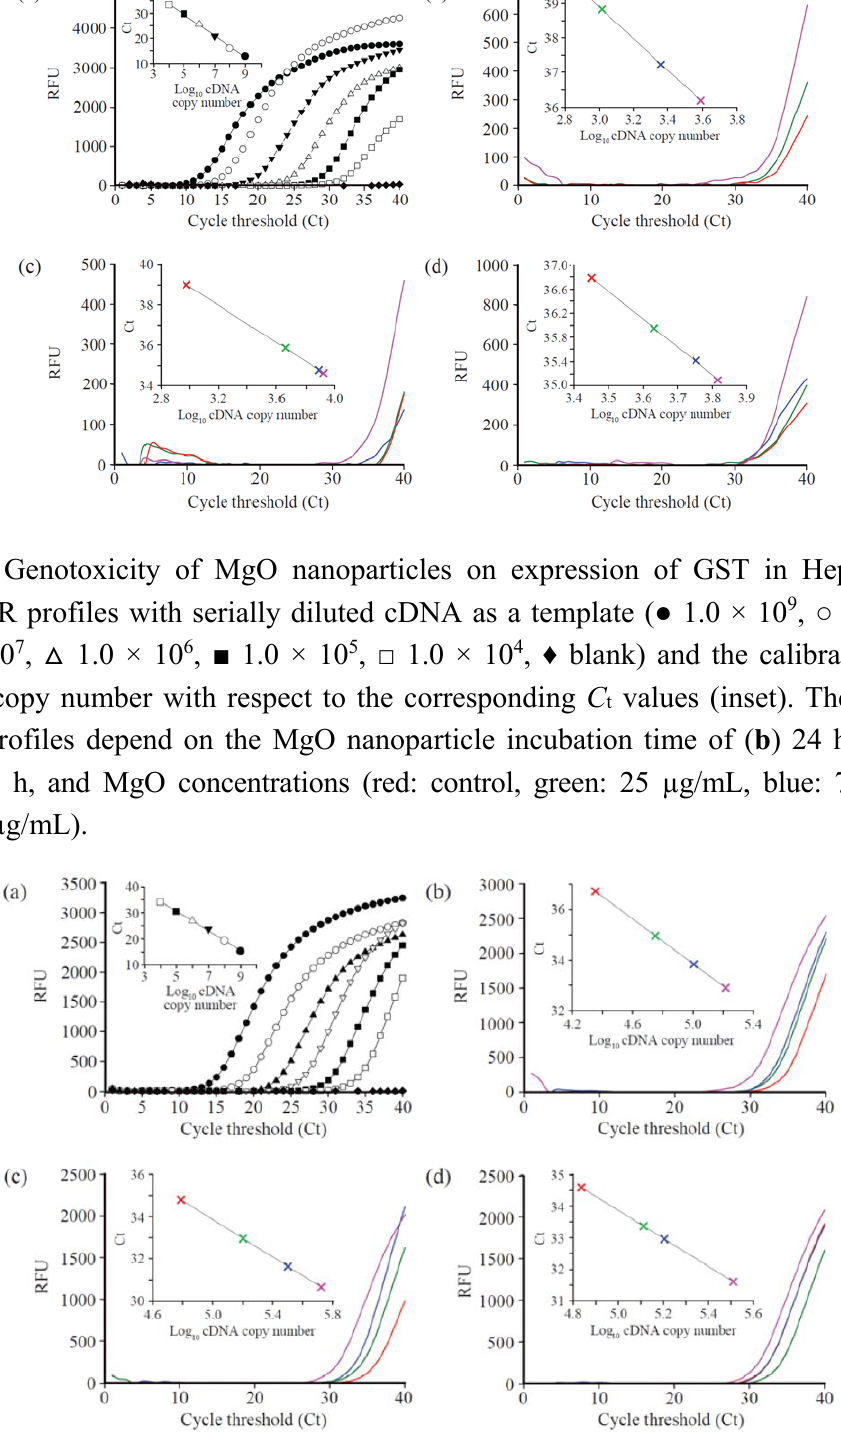
Figure 2. Genotoxicity of MgO nanoparticles on the expression of catalase in HepG2 cells. ( a ) RT-PCR profiles with serially diluted cDNA as a template (● 1.0 × 10 9 , ○ 1.0 × 10 8 , ▼ 1.0 × 10 7 , 1.0 × 10 6 , ■ 1.0 × 10 5 , □ 1.0 × 10 4 , ♦ blank) and the calibration curve of the cDNA copy number with respect to the corresponding C t values (Inset). The RT-PCR △ profiles depend on the MgO nanoparticle incubation time of ( b ) 24 h, ( c ) 48 h and ( d ) 72 h, and MgO concentrations (red: control, green: 25 µg/mL, blue: 75 µg/mL, pink: 150